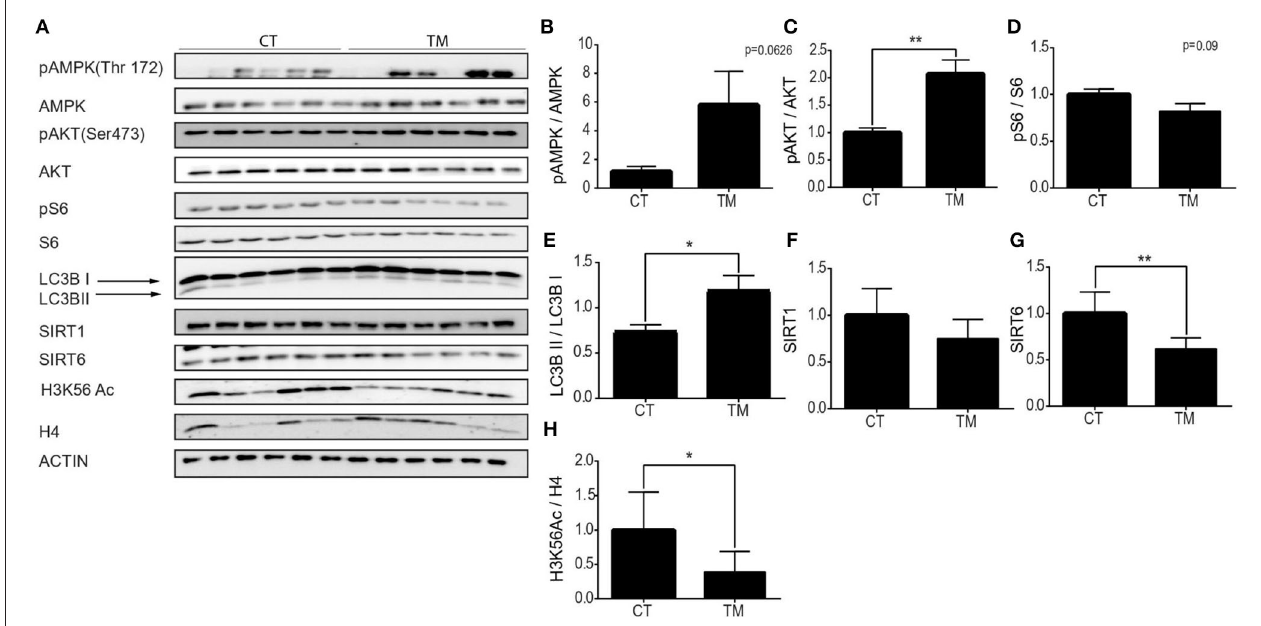
FIGURE 5 | Forced exercise activates AMPK and SIRT6 pathways in the hypothalamic region. (A) Representative Western blot analysis of p-AMPK, AMPK, pAKT, AKT, p-S6, S6, LC3B, SIRT1, SIRT6, and H3K56Ac in young (4 months) WT male mice in the hypothalamus, at rest (CT) or under long-term forced exercise (TM). Densities of the bands were normalized to actin, which served as an internal control. (B) Phosphorylated AMPK vs. unphosphorylated AMPK. (C) Phosphorylated AKT normalized to unphosphorylated AKT. (D) Phosphorylated S6 normalized to unphosphorylated S6. (E) LC3B II protein expression normalized to LC3B I protein expression. (F) SIRT1 and (G) SIRT6 protein expression normalized to actin. (H) H3K56Ac normalized to H4 in young H4 in young (4 months) WT male mice in the hypothalamus. The values shown are mean ± s.e.m., * p < 0.05, ** p < 0.01; (two-tailed t -test). In (A–H) n =